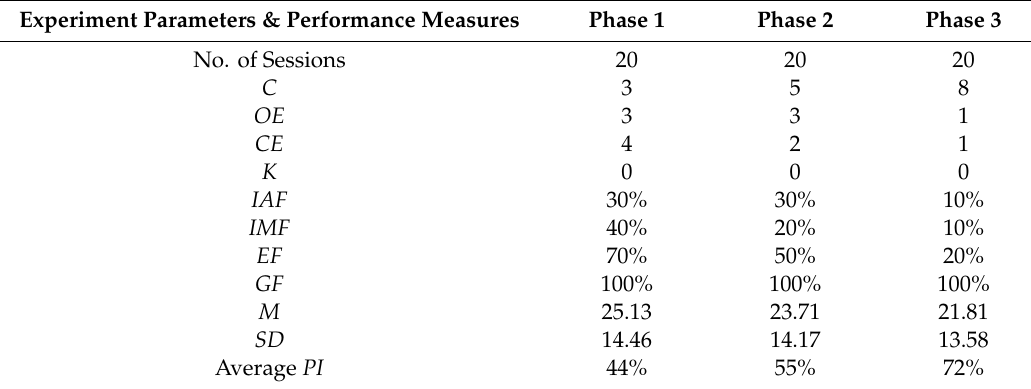
Table 1. Summary of statistical data obtained during the first part of the